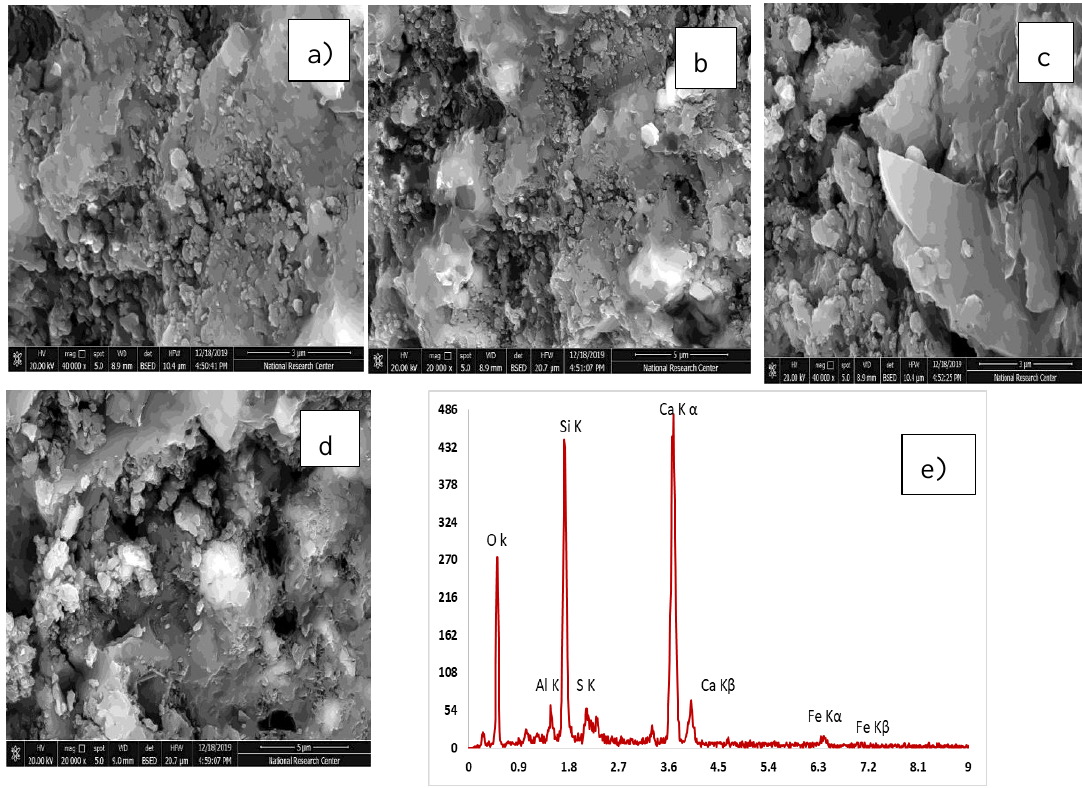
Figure 16. SEM and ( a – d ) SEM images at different magnification factor and ( e ) EDX for the UHPC mix incorporating 3% nano-rice husk ash.